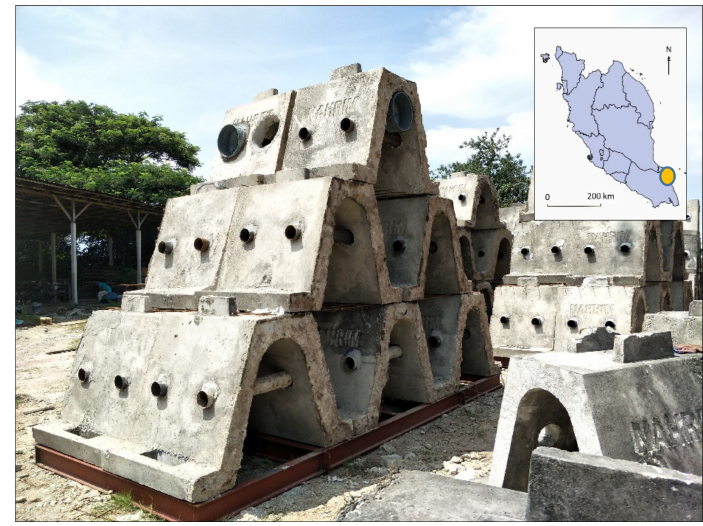
Figure 12. WABCORE as a wave breaker and artificial reef structure